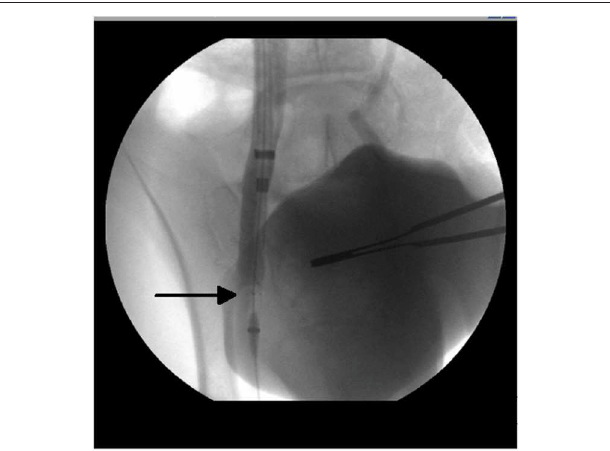
FIGURE 1 | Radiographic image from a venogram performed of the right external iliac vein with the test article (venous stent with polymeric inner valve—arrow) positioned in situ .